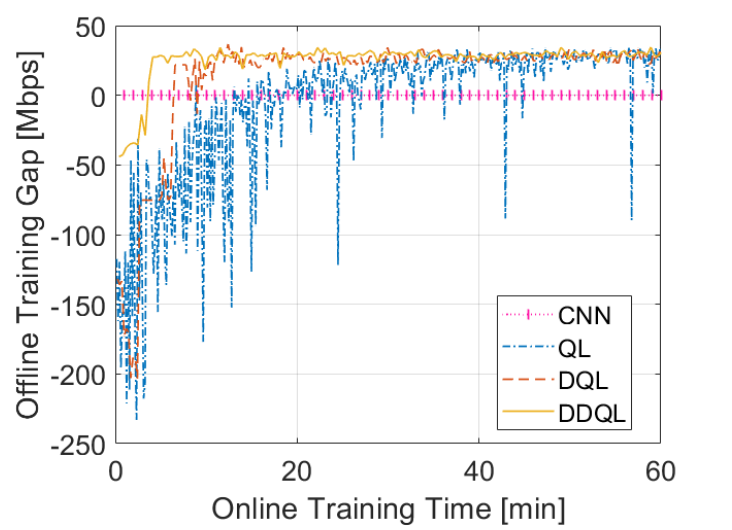
Figure 11. Performance gap of the online-trained algorithms concerning the performance of an algorithm trained offline (CNN). Note: The times obtained depend on the computer features used. If computer performance is increased, the time required will be considerably